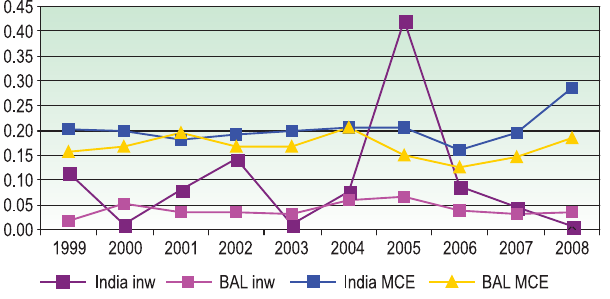
Fig. 9. FDI growth rates vs aggregated index MCE (the second